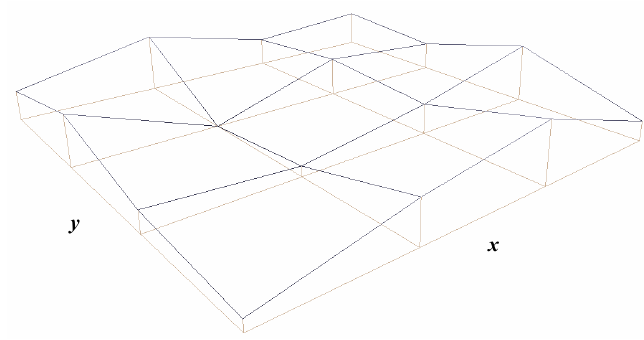
Figure 2. The surface constructed with the original set of data.